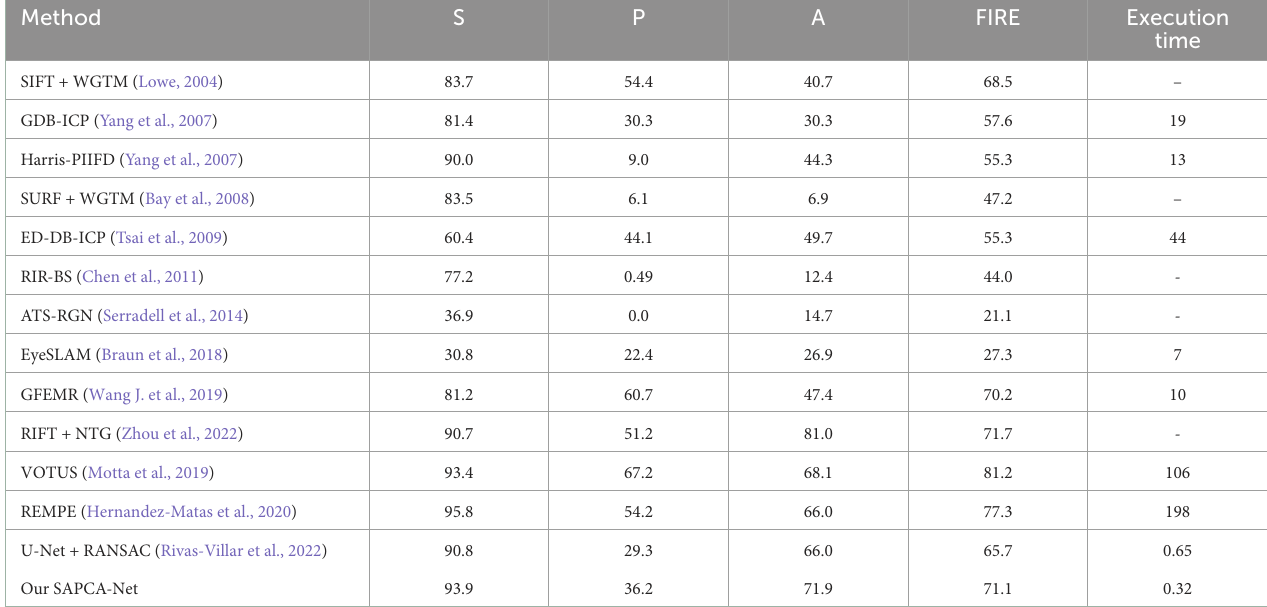
TABLE 4 Comparison to state-of-arts on FIRE